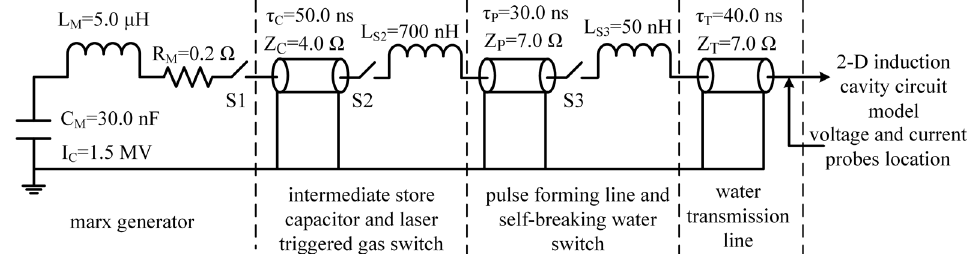
FIG. 4. A pulse generation circuit is used to drive the 2D circuit model of induction cavity which includes Marx generator, intermediate store capacitor, laser triggered gas switch, PFL, self-breaking water switch and water transmission line. The laser triggered gas switch and self-breaking water switch are modeled with ideal elements without consideration of capacitance and resistance. The oil prepulse switch is also not taken into account. The quantities I C , C M , L M and R M are the equivalent charging voltage, capacitance, inductance and resistance of the Marx generator, respectively. S 1 , S 2 and S 3 represent the switches in the Marx generator, laser triggered gas switch and self-breaking water switch, respectively. τ C and Z C are the transit time and impedance of the intermediate store capacitor, respectively. L S 2 is the inductance of laser triggered gas switch. τ P and Z P are the transit time and impedance of the PFL, respectively. L τ Z S 3 is the inductance of self-breaking water switch. T and T are the transit time and impedance of the water transmission line,